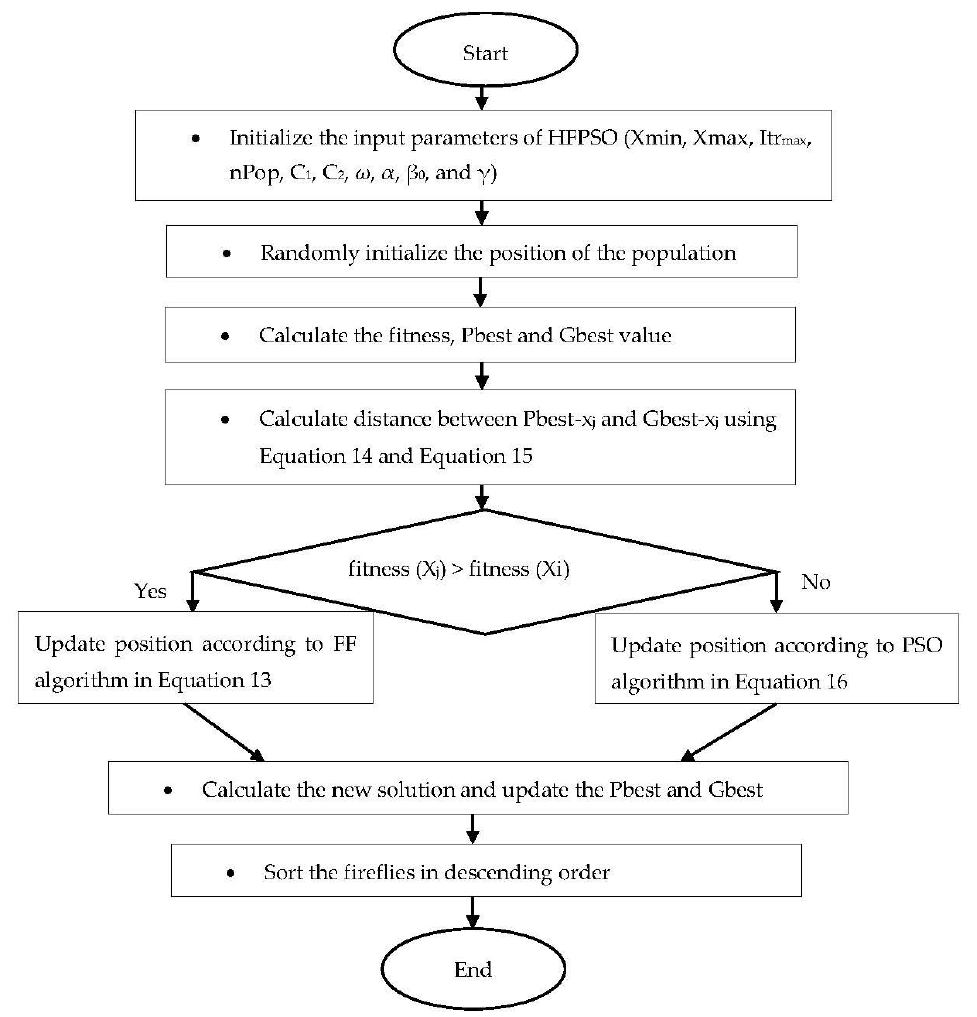
Figure 6. Flowchart of proposed hybrid firefly and particle swarm optimization (HFPSO).